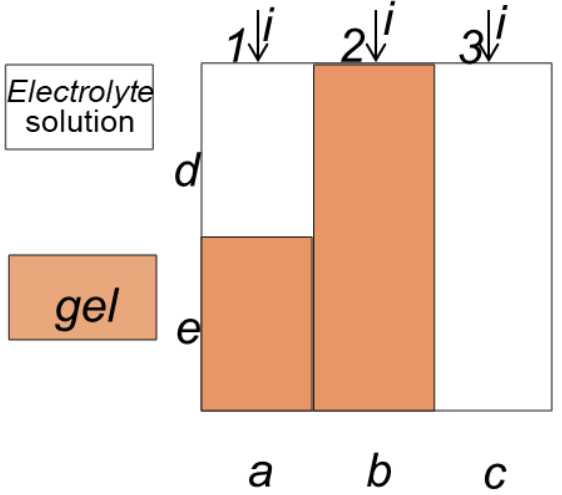
Figure 5. Scheme of current transfer in ion-exchange material within ETWM.